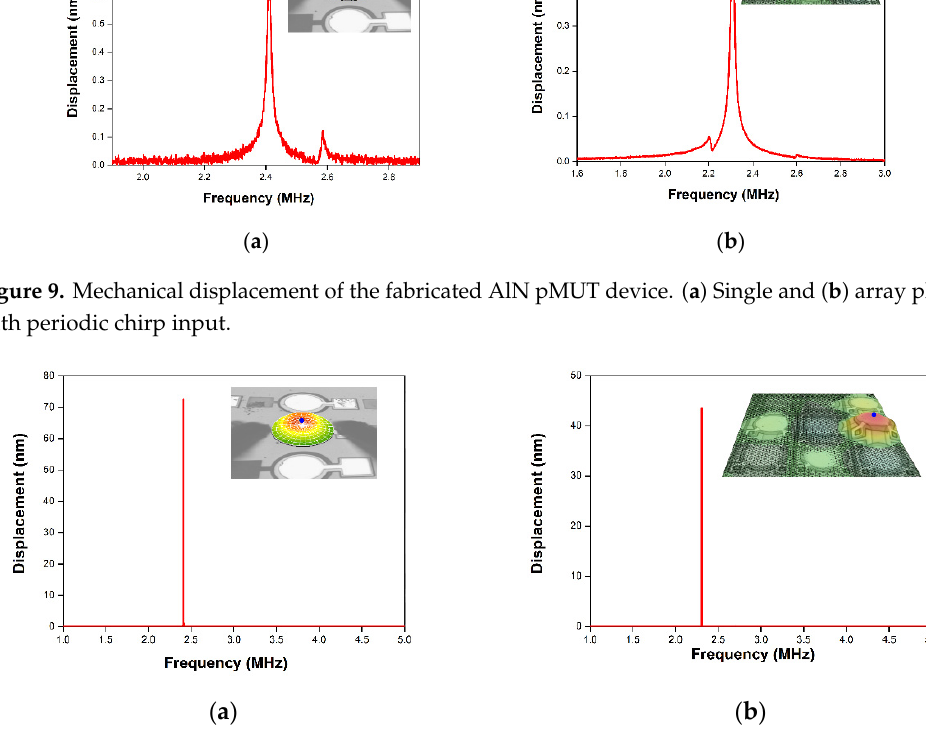
Figure 10. Mechanical displacement of the fabricated AlN pMUT device. ( a ) Single and ( b ) array pMUT with sinusoidal input.